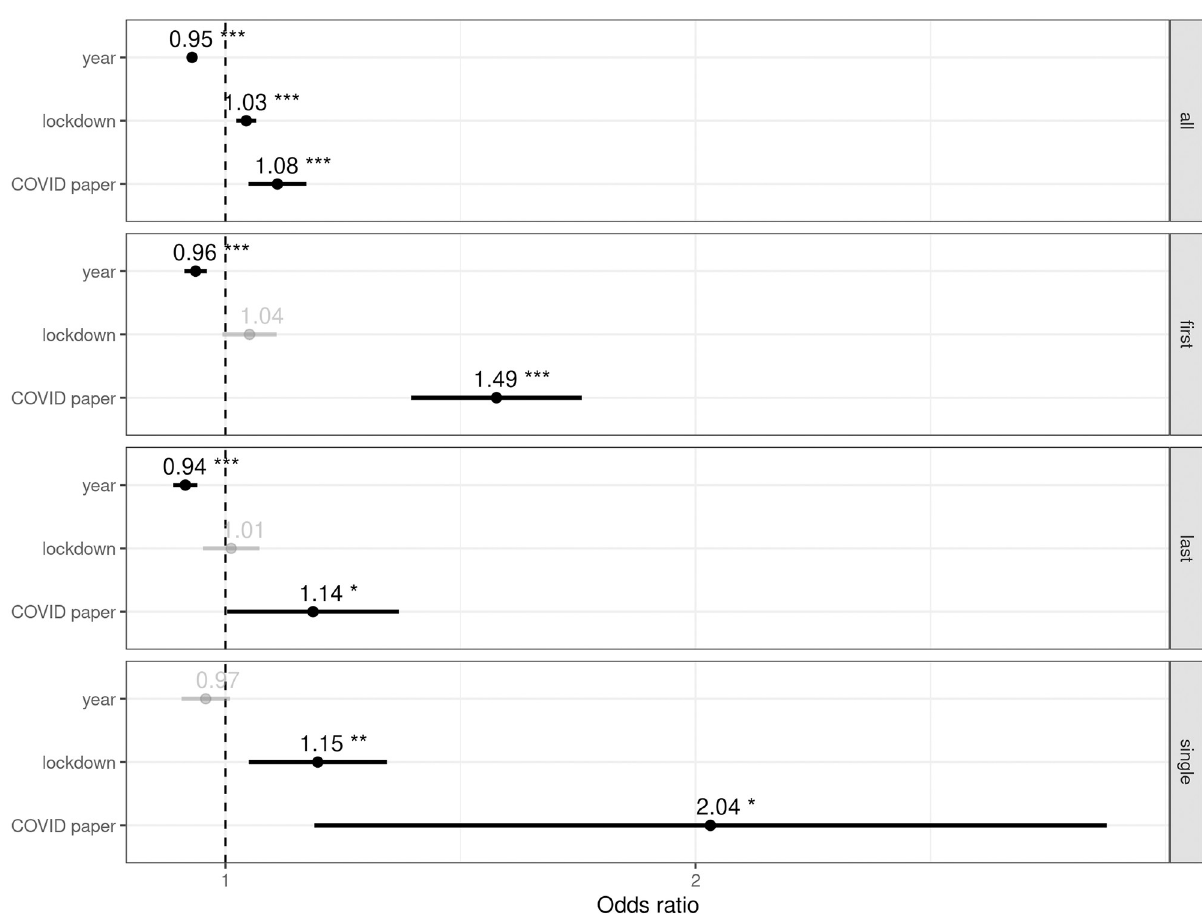
Fig 3. Relative effect sizes. Odds ratio with 95% CIs for the fixed effects in all the models considered, from top to bottom: (1) all authors, (2) first authors, (3) last authors, and (4) single authors.